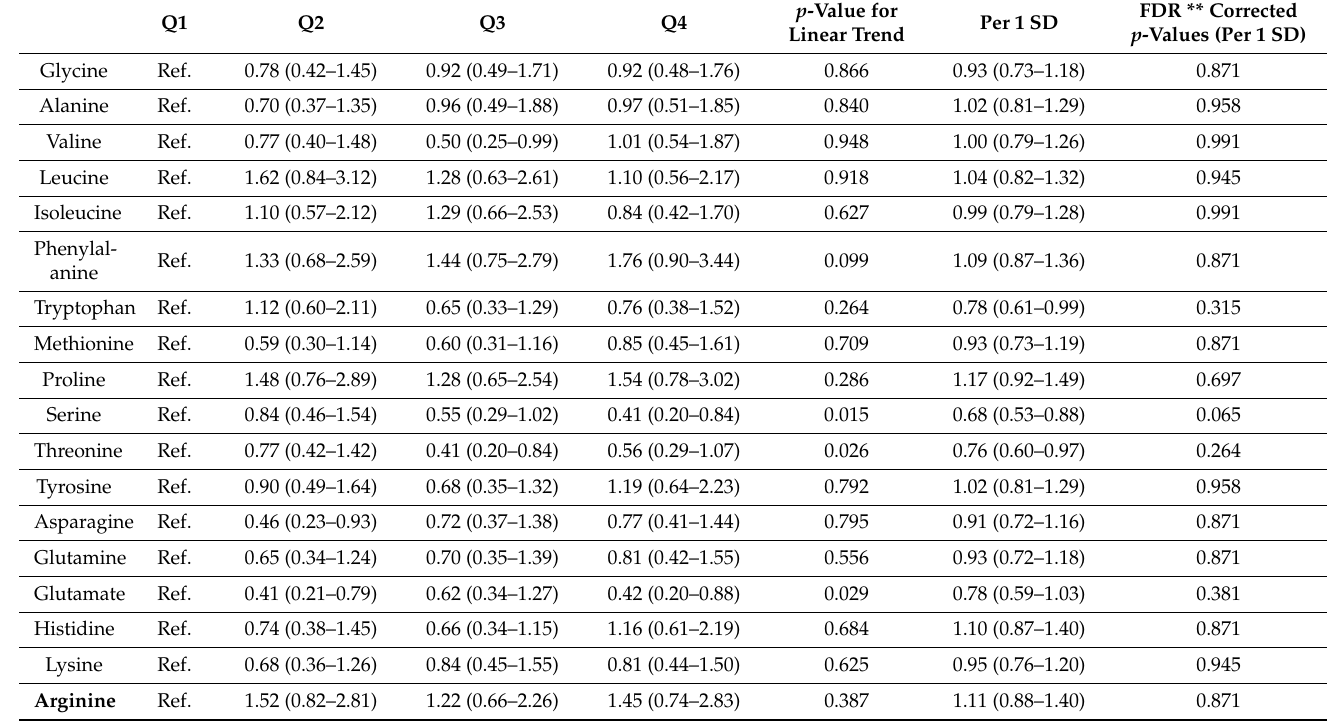
Table 2. Association * between plasma amino acids and incident peripheral artery disease (PAD).